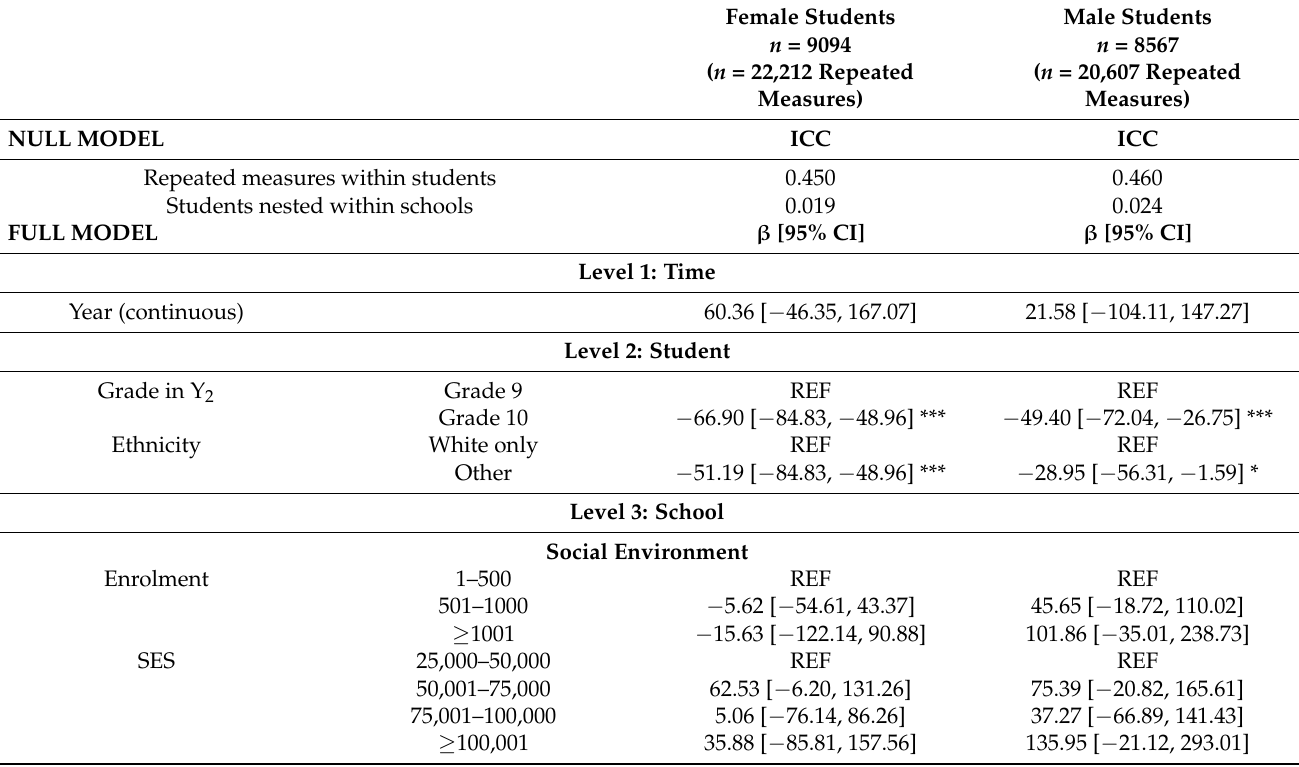
Table 3. Fixed effects from longitudinal multilevel regression of student- and school-level variables associated with weekly minutes of MVPA in students attending schools that participated in Year 2 (2013–2014), Year 3 (2014–2015), and Year 4 (2015–2016) of the COMPASS Study in Ontario and Alberta,